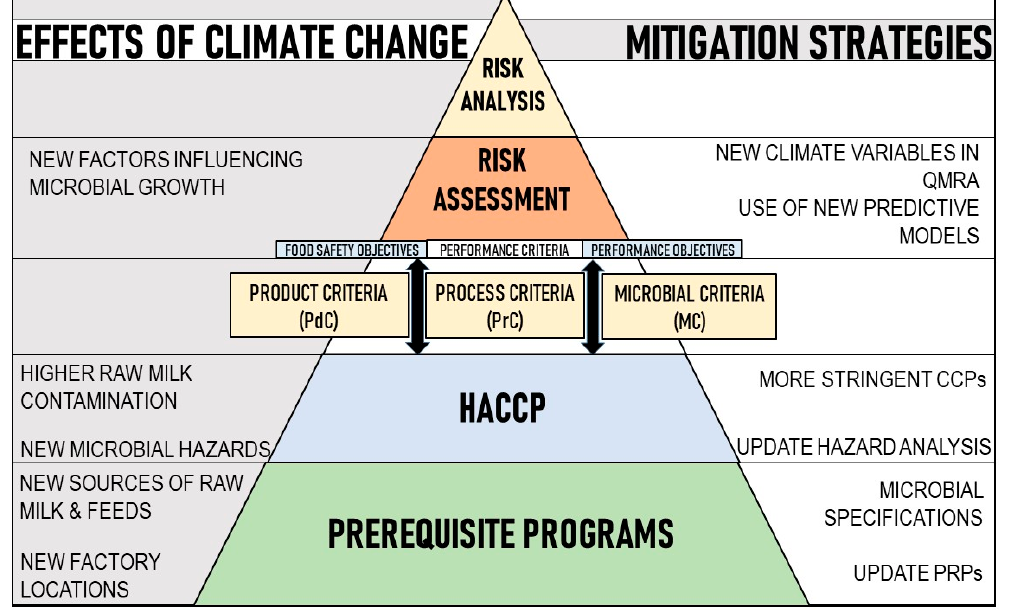
Figure 3. Food safety management approach to climate change: from the effects of climate change to mitigation strategies (adapted from [35,41]).